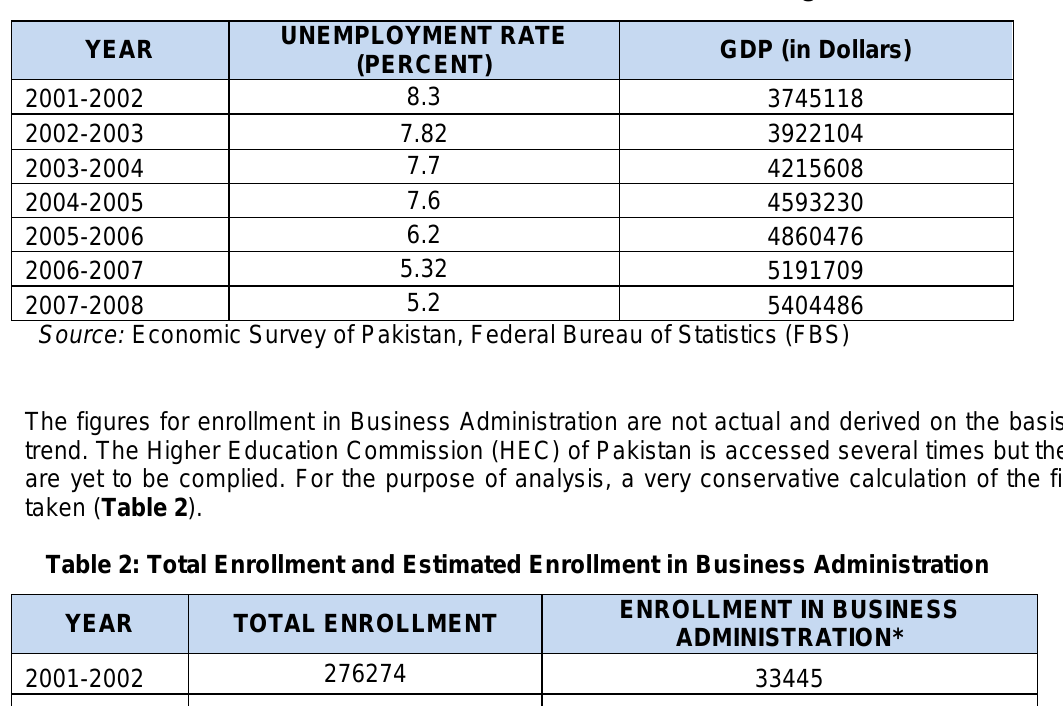
Table 1: Economic Indicators for the Years 2001 through 2008